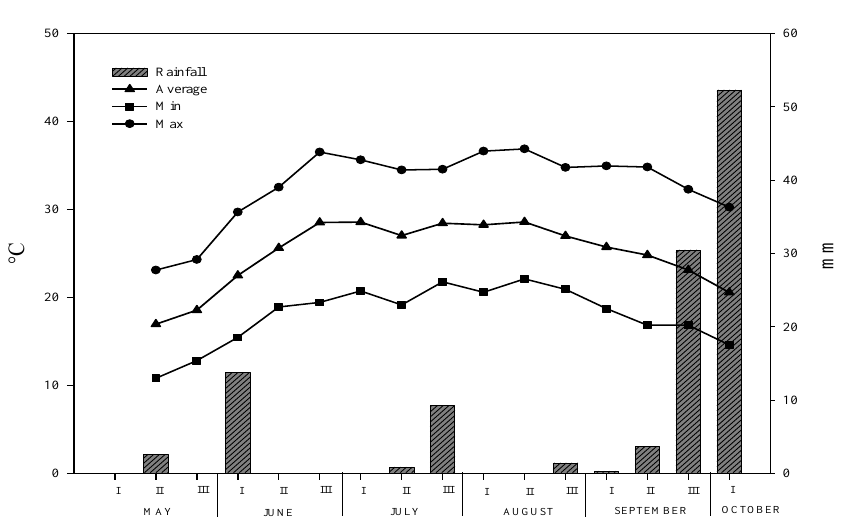
Figure 1. Maximum and minimum air temperature trends, and rainfall during the growing period of hemp.